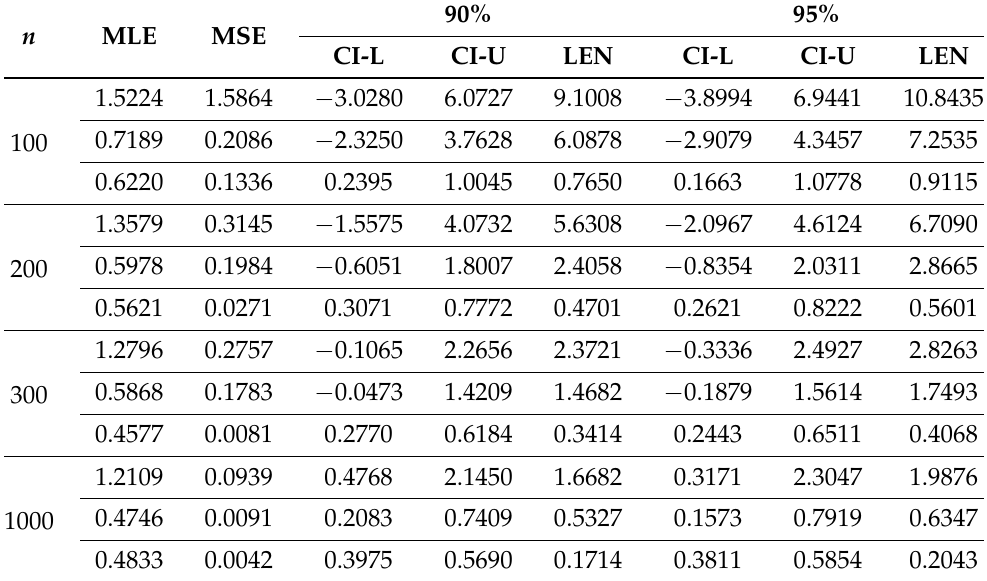
Table 4. Numerical values of the MLEs, MSEs, CI-Ls, CI-Us, and LENs for the parameters of the UG/G model for